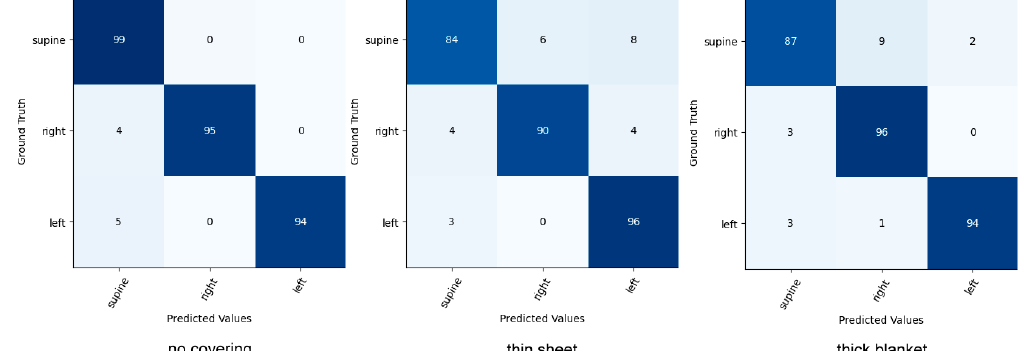
Figure 8. Confusion matrix for head pose classification on the SLP dataset.